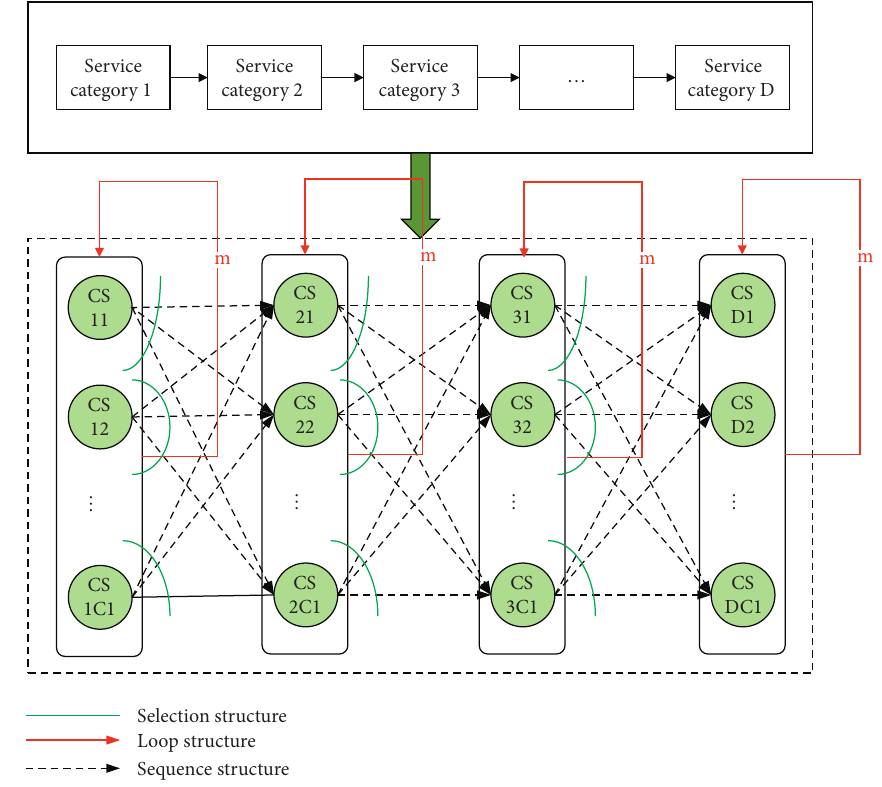
Figure 4: The QoS composition process of